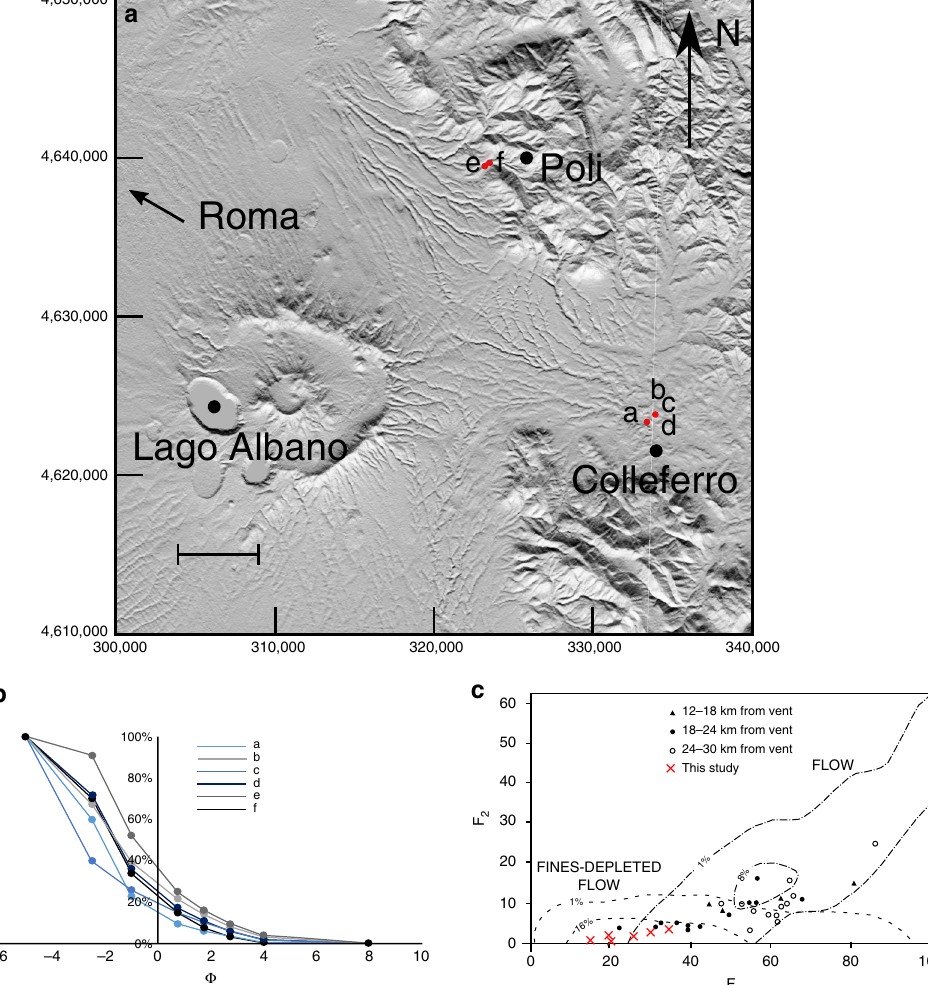
Fig. 5 Grain-size data for samples from the Pozzolane Rosse ignimbrite. a Map of sample locations. Scale bar = 5 km. Sample a is from the massive facies, sample b, c and d from the undulated bedding facies, and sample e and f from backset bedforms within this facies. b Grain-size distribution curves for samples from this study. Note the dominance of coarse grains and paucity in the <63 μ m (4 ϕ ) fraction. The grain-size data are given in Supplementary Table 2. c Plot of weight percentage fi ner than 63 μ m (F 2 ) vs. weight percentage fi ner than 1 mm (F 1 ), after Walker 25 . Black symbols are PR ignimbrite samples from Giordano and Dobran 58 , red crosses show the PR ignimbrite samples from this